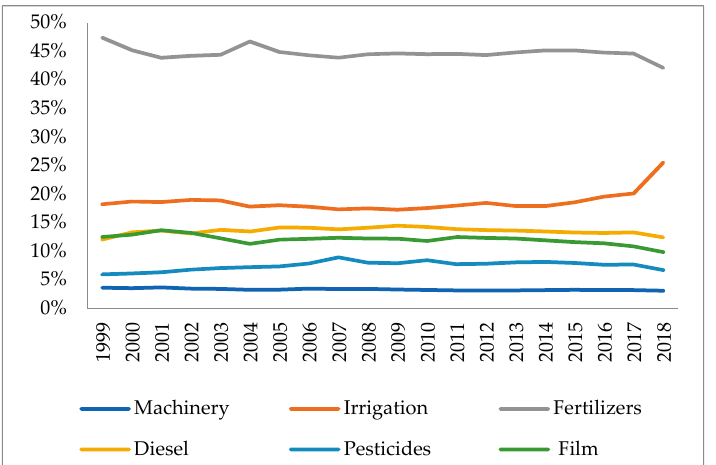
Figure 3. Proportion of carbon emissions from agricultural element inputs in plantation. Data Source: calculated by the authors.